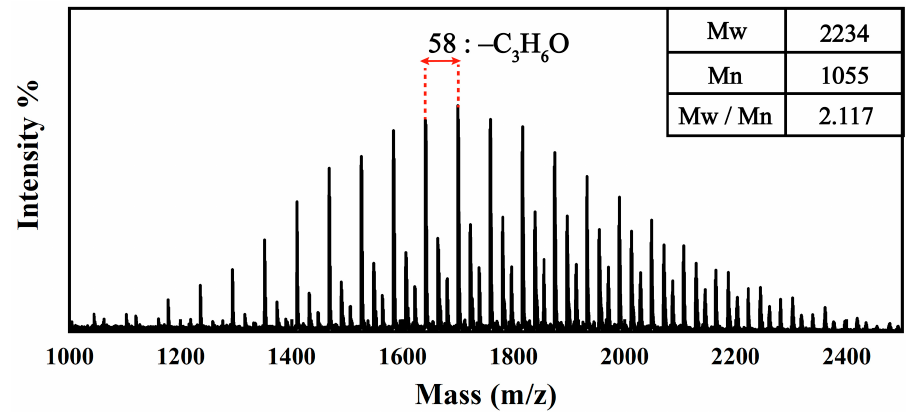
Figure 3. The MS spectra of the JD2000.